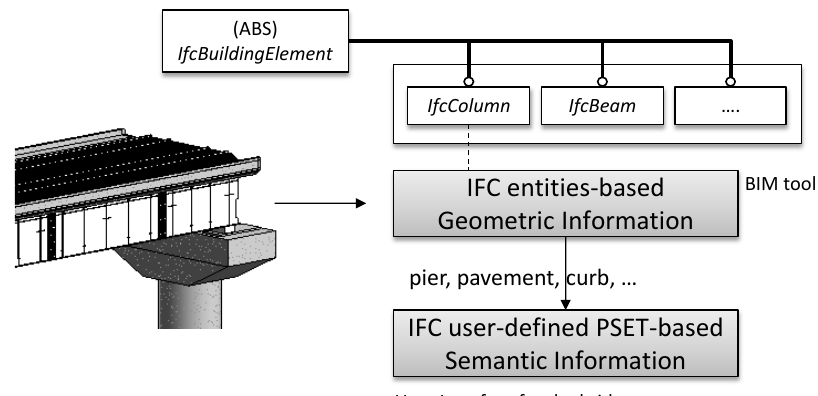
Appl. Sci. 2018 , 8 , x FOR PEER REVIEW Figure 6. Information reassigning concept for the bridge information modeling. Figure 6. Information reassigning concept for the bridge information modeling.